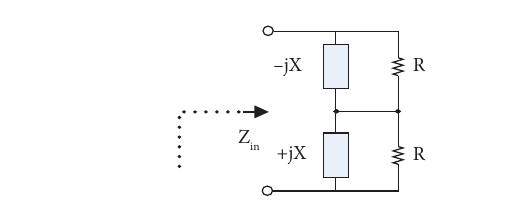
Figure 4: Structure of the two basic resistance compression